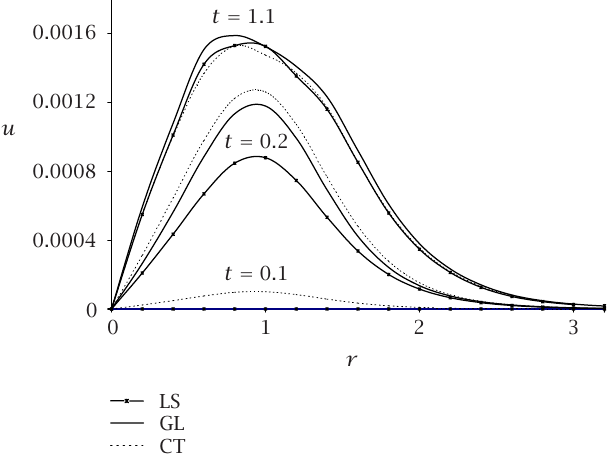
Figure 5.2. Radial displacement distribution in the middle